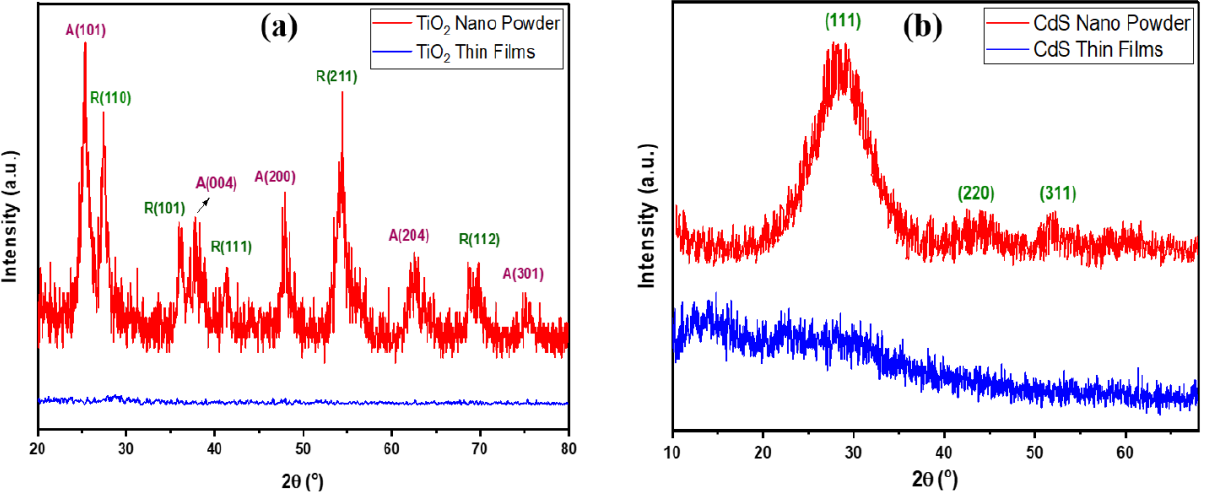
Figure 5. ( a ) XRD pattern of TiO 2 nanopowder and thin film; ( b ) XRD pattern of CdS nanopowder and thin film .